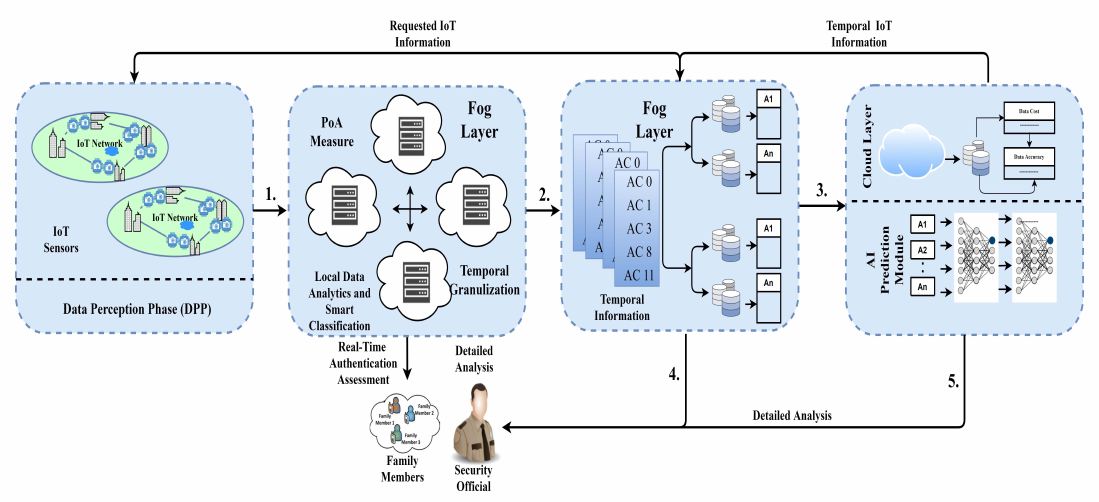
Figure 2. Modular Framework for Smart Intruder